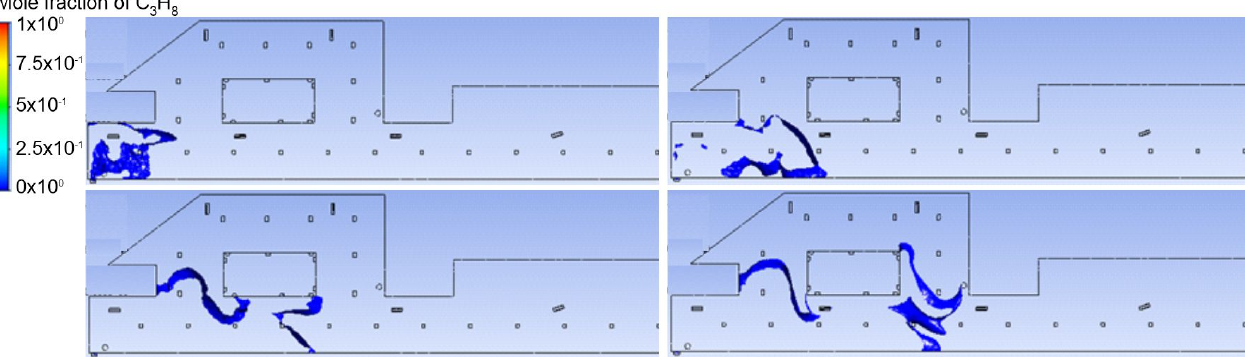
Figure 17. Trace amount of LPG near the end of dispersion for A source.